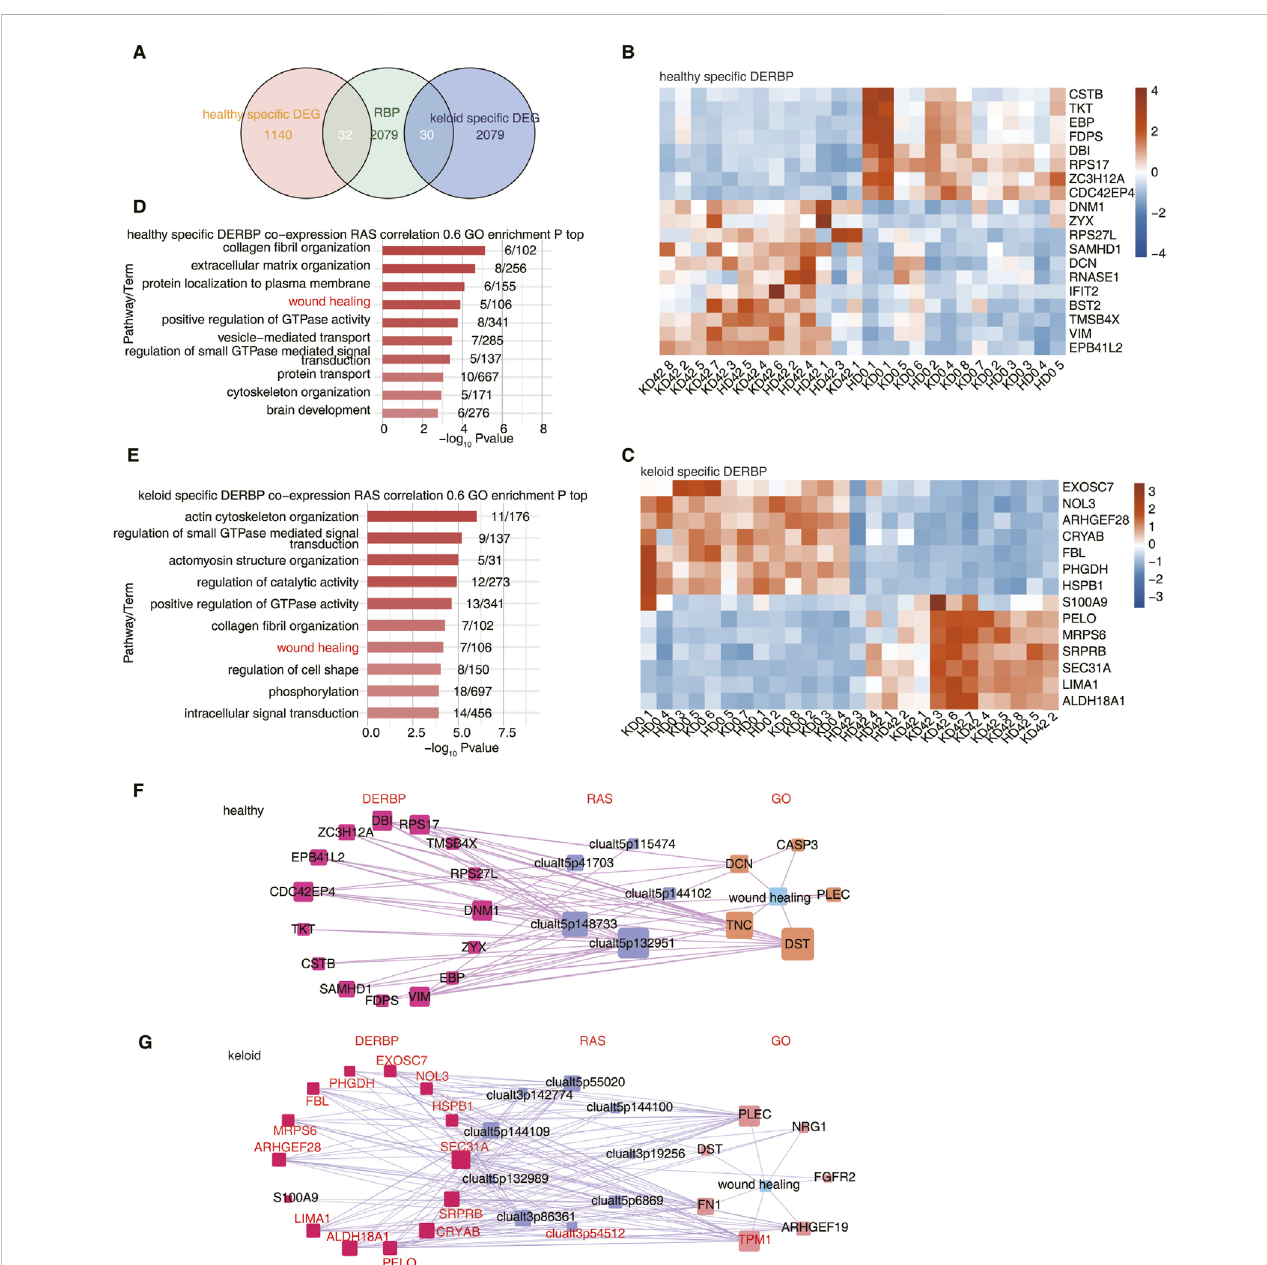
FIGURE 4 Differentially expressed RBPs potentially affect AS of wound healing-associated genes in KPI and HC. (A) Venn diagram showing the overlap of DEG and RBP. (B) The Heatmap showing the expression pro fi le of HC-speci fi c DERBP. (C) The Heatmap showing the expression pro fi le of KPI-speci fi c DERBP. (D) Bar plot showing the most enriched GO biological process results of RAS co-expressed by speci fi c DERBP in the HC group. Cutoffs of p ≤ 0.01 and Pearson coef fi cient ≥ 0.6 or ≤ − 0.6 were applied to identify the co-expression pairs. (E) Bar plot showing the most enriched GO biological process results of RAS co-expressed by speci fi c DERBP in the KPI group. Cutoffs of p ≤ 0.01 and Pearson coef fi cient ≥ 0.6 or ≤ − 0.6 were applied to identify the co-expression pairs. (F) Network diagram showing the wound healing pathway of RAS co-expressed by speci fi c DERBP in HC. (G) Network diagram showing the wound healing pathway of RAS co-expressed by speci fi c DERBP in KPI. The red marked DERBP stands for Pearson coef fi cient ≥